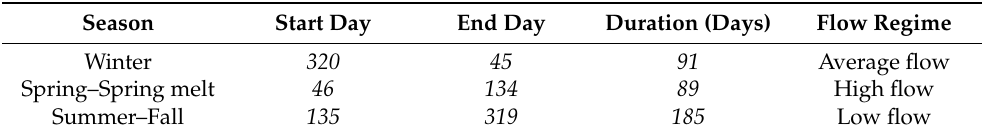
Figure 2. Hydrograph of the central Grand River at Blair (146 km from headwaters). Daily discharge (2010 to 2013) compared to monthly average discharge (2006–2013) for seasonal demarcation by flow regime. River discharge was obtained from the Historical Hydrometric Data Search (Water Survey of Canada) and from the Grand River Information Network (GRIN Open Data Licence v1.0). Table 1. Seasonal demarcation (in Julian days) based on monthly average discharge (solid line in Figure 2). Flow regime based on deviations of monthly average discharge relative to yearly average discharge (dotted line in Figure 2). Data from the Grand River Information Network (GRIN Open Data Licence